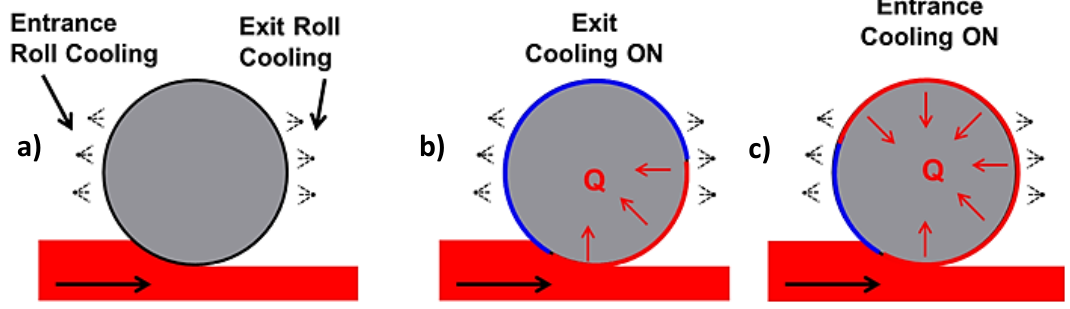
Figure 6. Schematic representation of the position of the cooling units ( a ) and the influence of only exit cooling ( b ) and only entry cooling ( c ) on the energy balance.